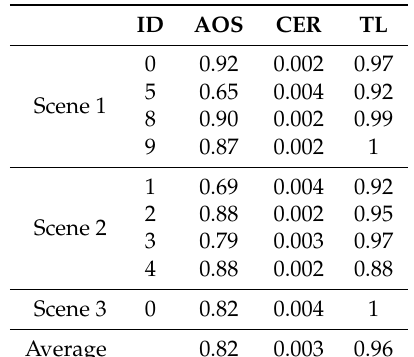
Table 2. Results of the classical machine learning tracking system applied to all three evaluation scenes. For each scene the resulting measures according to Equations (2)–(4) are given. Tracking IDs are assigned randomly to each particular track. The last row highlights the performance of this system averaged over all